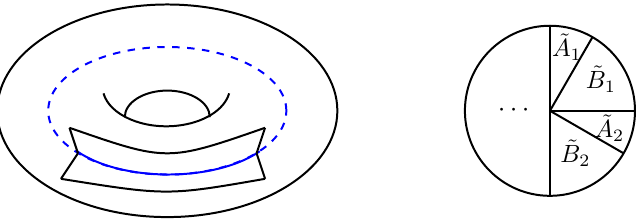
Figure 7 . (Color online) Left: front view of the pictorial representation of (cid:26) A . Notice that the cutaway wedge runs along the longitude (non-contractible loop) of the solid torus, with its vertex on the horizon. Right: graphical representation of tr (cid:26) n . The disk is perpendicular to the A